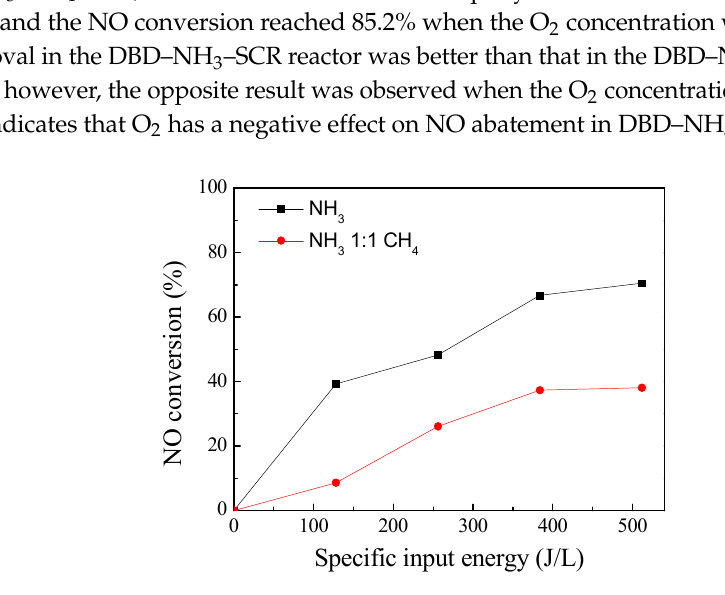
Figure 2. Effect of specific input energy (SIE) on the NO conversion of the DBD–NH 3 –SCR and DBD– NH 3 –CH 4 –SCR processes. Reaction conditions: 400 ppm NO, O 2 free, balance N 2 . (1) DBD–NH 3 –SCR: 90 ppm NH 3 . (2) DBD–NH 3 –CH 4 –SCR: 45 ppm CH 4 and 45 ppm NH 3 .